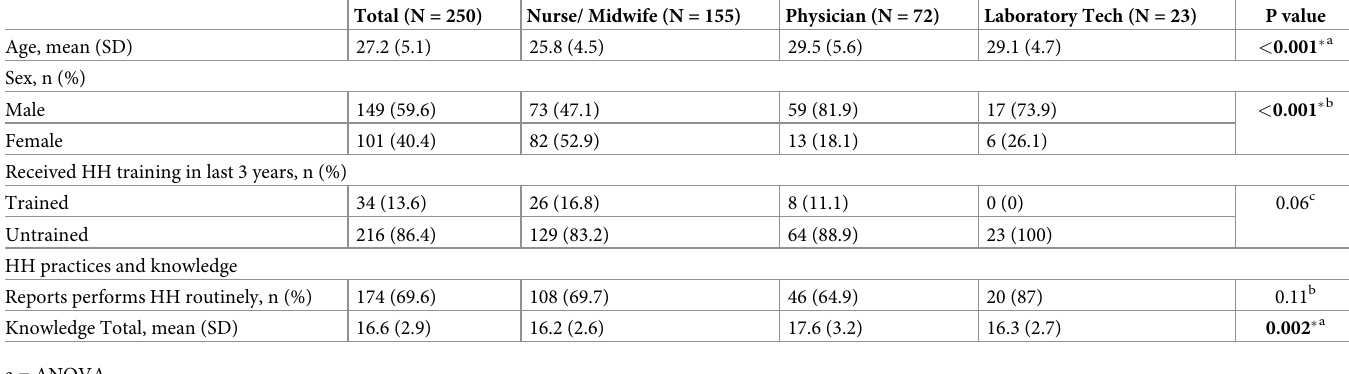
Table 1. Questionnaire participant demographics, knowledge, and attitudes between professional